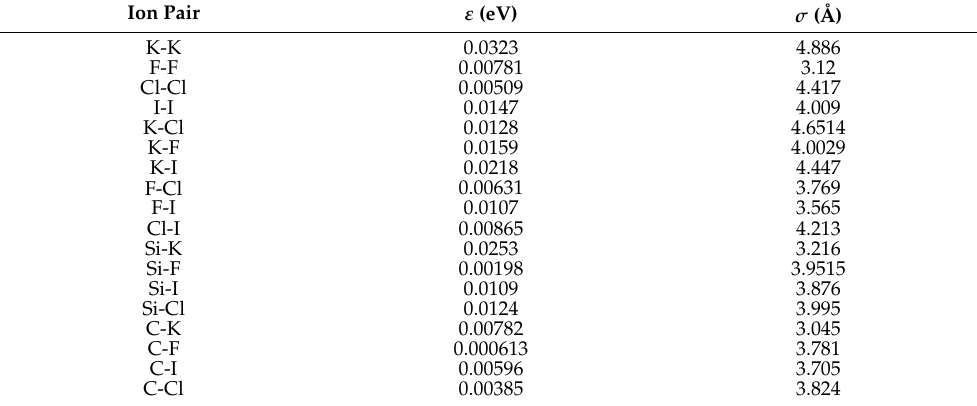
Table 1. Parameters of the Lennard–Jones potential describing the interaction in the melt. Data from [18]. Ion Pair ε (eV)